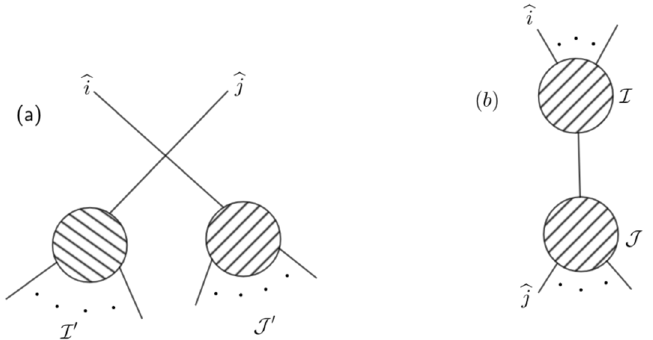
Figure 1 . (a) Diagrams contributing to boundary term B n . (b) Diagrams contributing to the pole part P n